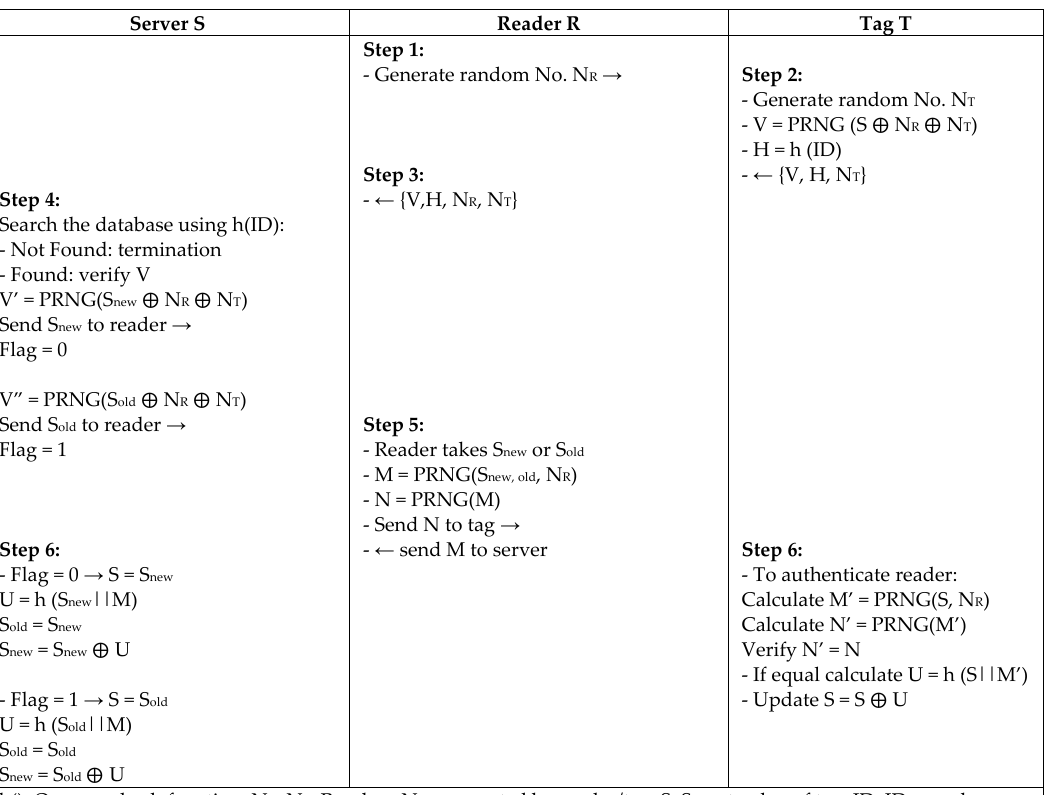
Figure 21. Efficient Authentication Protocol (SEAS) by Dass and Om.